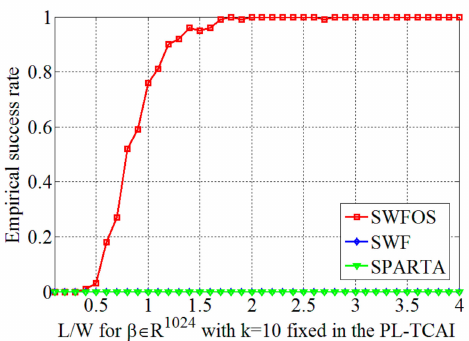
Figure 5. Performance results of the SWFOS algorithm and other sparse algorithms in the PL-TCAI